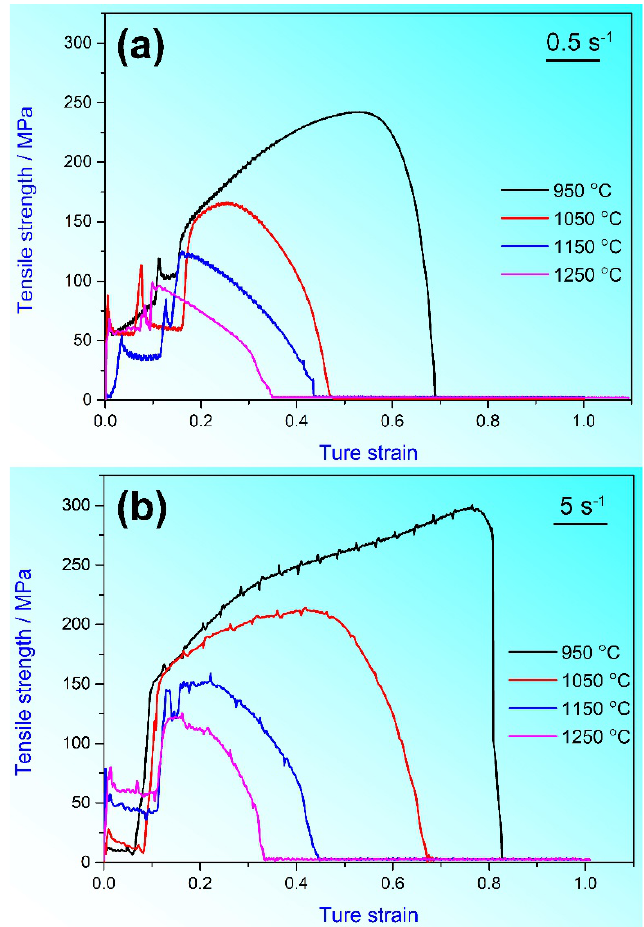
Figure 8. The hot tensile curves of the specimens at the strain rate of 0.5 ( a ) and 5 s −1 ( b ).